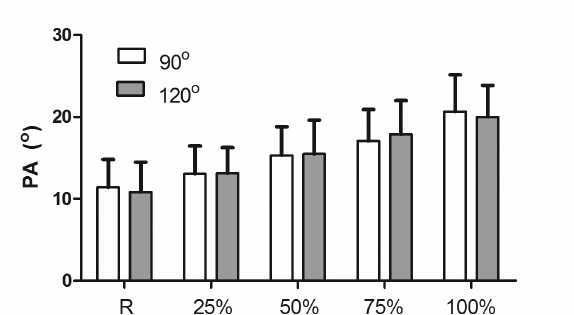
Figure 2 - Mean value (+1 standard deviation) of the pen- nation angle (PA) measured with the resting muscle (R) and during the isometric tests at 25 % , 50 % , 75 % of the MVC (100 % ) with the knee at 90º and 120º.